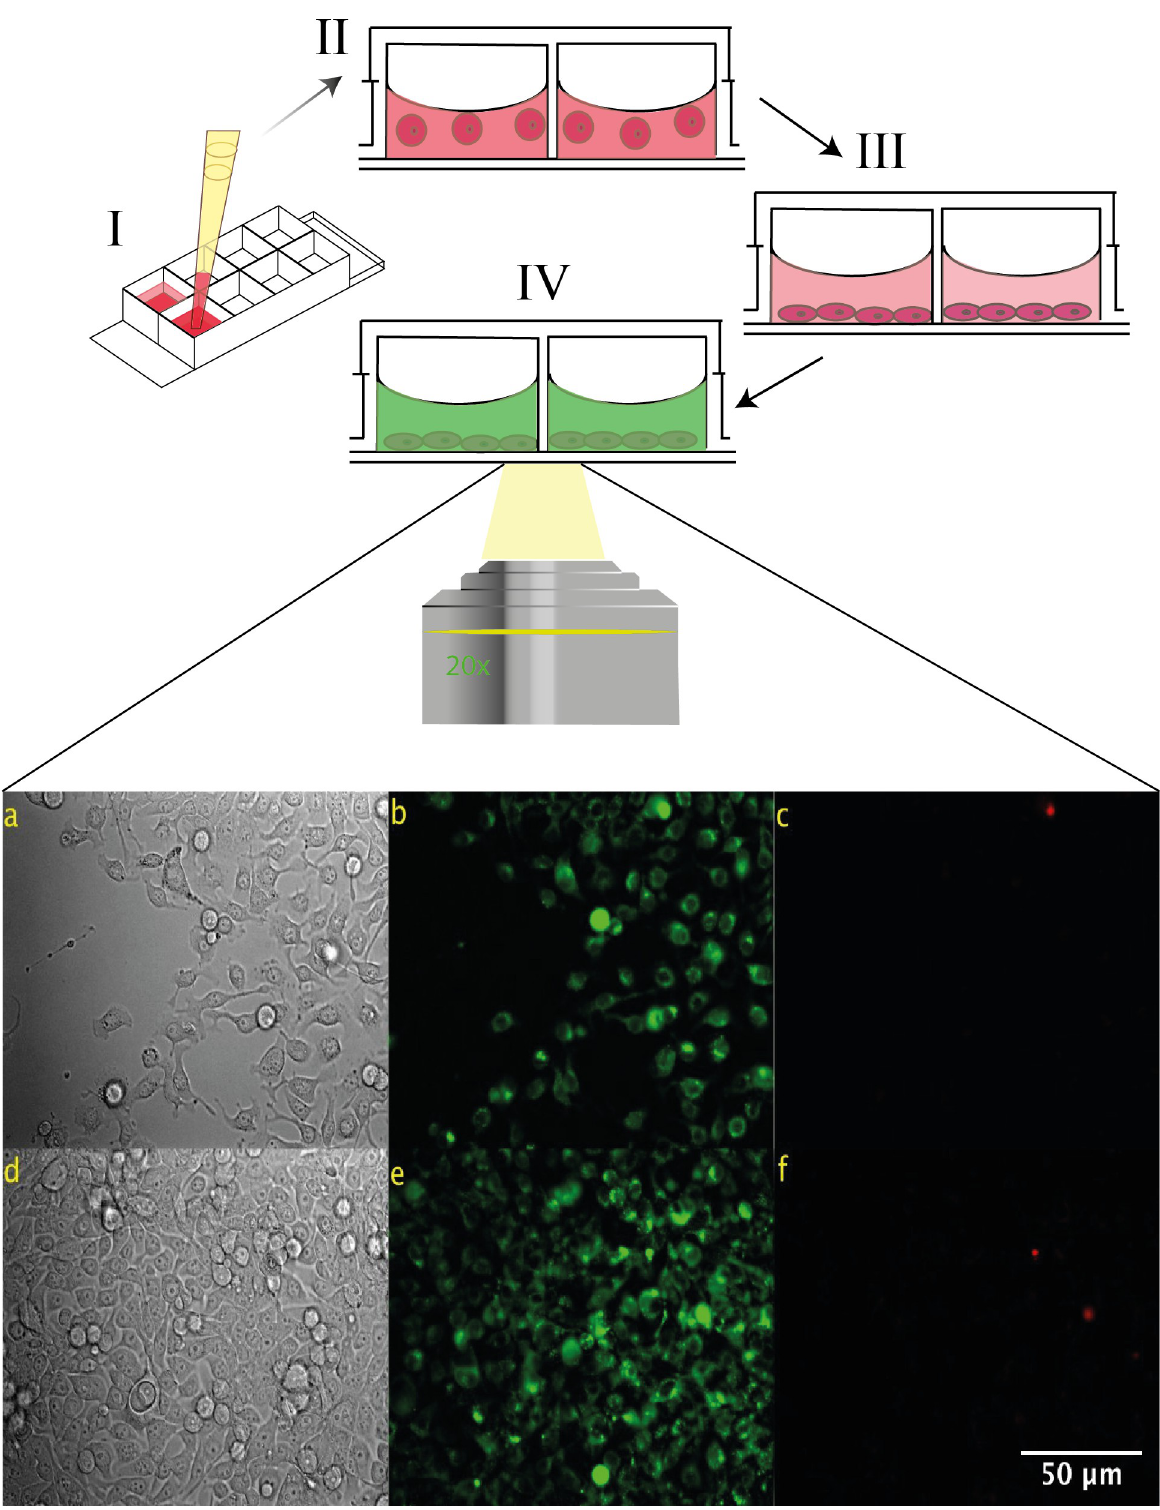
Fig 1. Representative microscopy images of breast cancer cells after three days in the microdevice. (a,d) Brightfield images of the culture. (b,e) Fluorescence images of cells after treatment with the autophagy kit, which preferentially labels autophagous vacuoles, shown here in green (c,f) Fluorescence images after treatment of the cells with CD. Dead cells are shown in red.